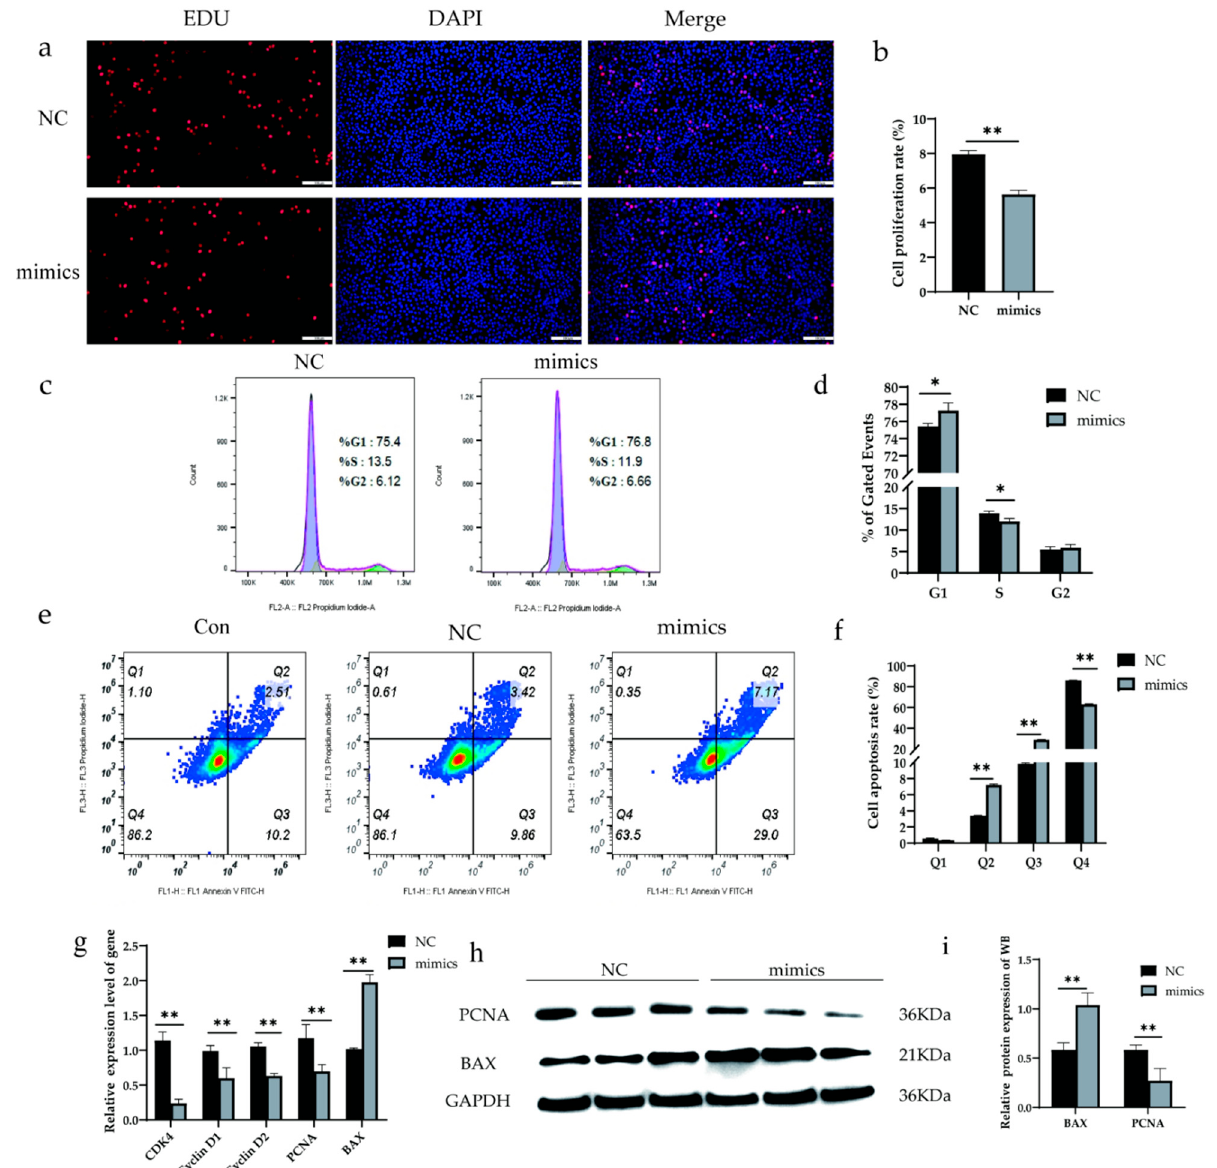
Figure 5. Overexpression of xeno-miR168b inhibited proliferation and promoted apoptosis in BMECs. Data are given as the mean ± SD for n = 3/group. * p < 0.05 or ** p < 0.01 were considered statistically significant. ( a , b ) Cell proliferation detected via EdU analysis; ( c , d ) flow cytometry anal- ysis of cell cycle in BMCEs treated as indicated; ( e ) proportion of apoptotic cells detected via